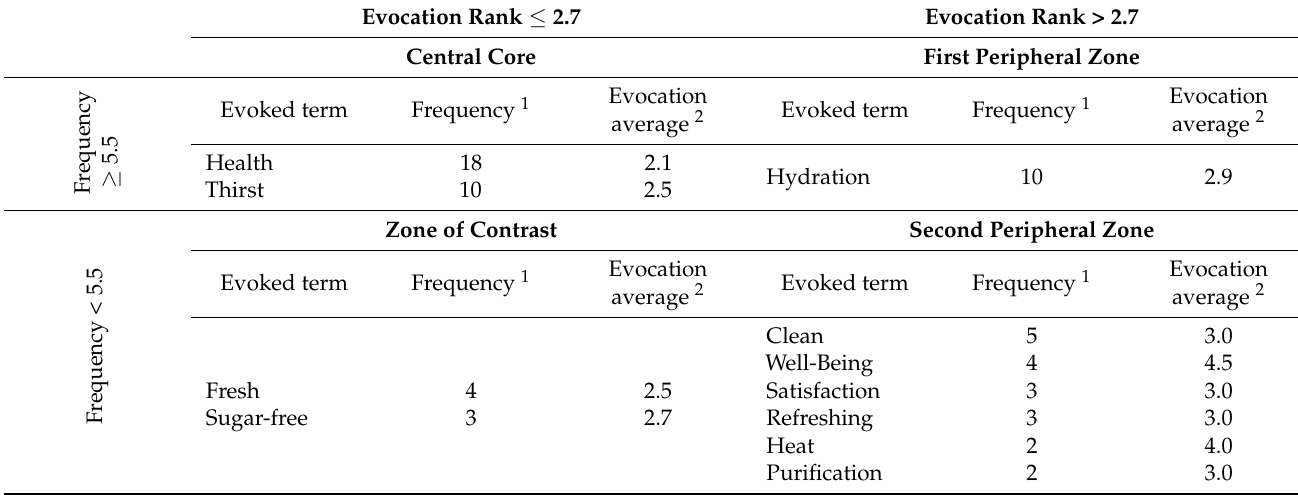
Table 2. Prototypic analysis of the social representation of “drinking water” in parents of children from elementary schools in Zapopan, Mexico ( n = 23).